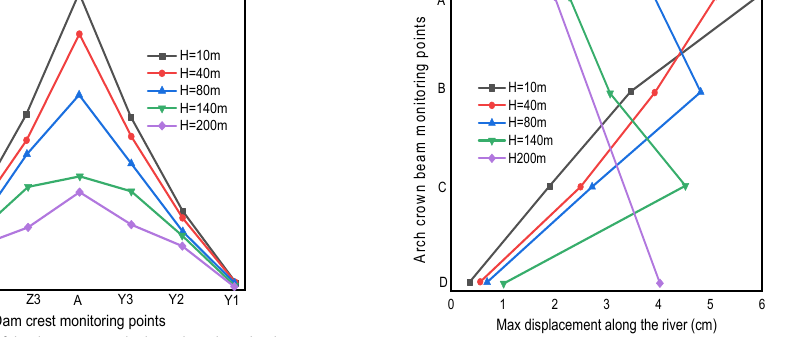
(b) Max displacement of the arch crown beam monitoring points along the river